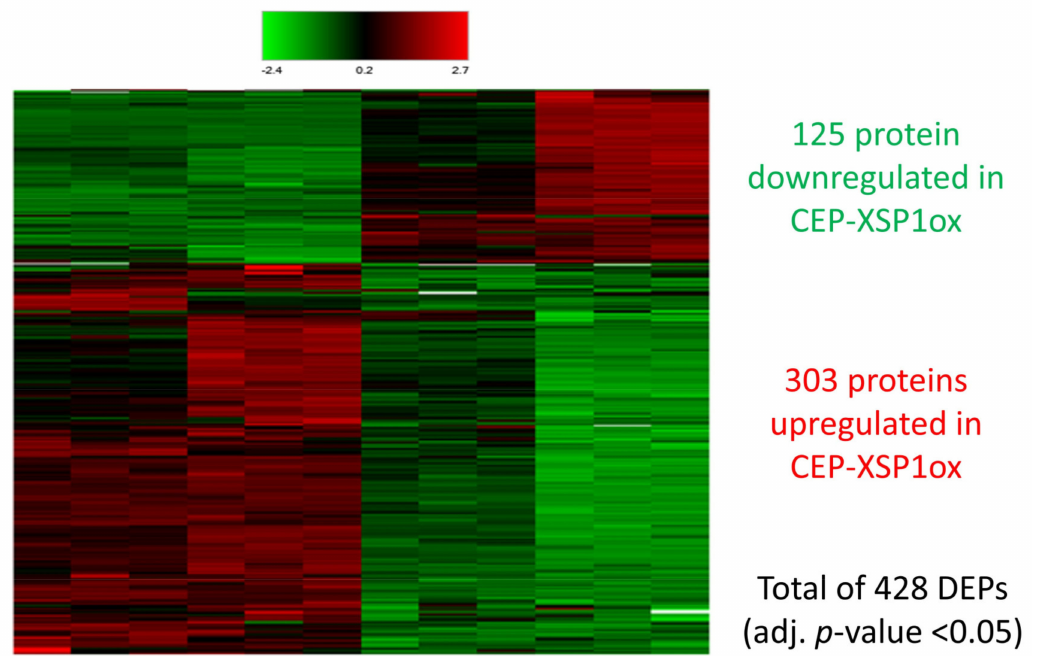
Figure 6. Heatmap representing clustering of differentially expressed proteins (DEPs) in control and CEP-XSP1ox hairy root identified in label-free proteomic quantification analysis following LC- MS/MS. Statistical significance of quantified proteins was analyzed by the Benjamini–Hochberg method, with proteins with adjusted p -values < 0.05 considered as DEPs. Relative fold changes are indicated on the log2 scale. Numbers of down- and upregulated proteins in CEP-XSP1ox are indicated in green and red, respectively.